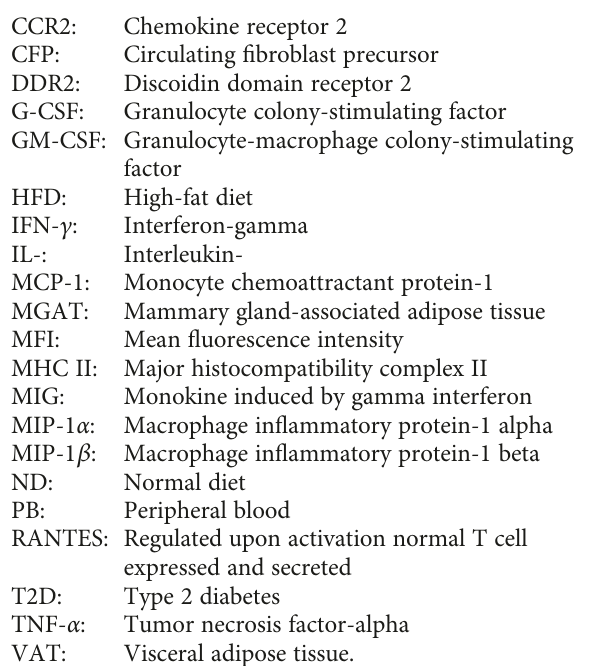
Supplementary Table 1: comparison of high-fat diet (HFD) and normal diet (ND). Supplementary Figure 1: fl ow cytomet- ric controls (unstained cells) from MGAT, VAT, and periph- eral blood of ND-fed, control female C57BL/6 mice. Supplementary Figure 2: total myeloid-derived CD45 + DDR2 + cells in MGAT and VAT of ND- vs. HFD-fed mice. Supple- mentary Figure 3: fl ow cytometric analysis of CD45 + DDR2 - cells in MGAT, VAT, and peripheral blood of ND- vs. HFD-fed mice. Supplementary Figure 4: fl ow cytometric anal- ysis of total CD3e + T cells and CD3e + CD4 + T cells in MGAT, VAT, and peripheral blood of ND- vs. HFD-fed mice. Supple- mentary Figure 5: mediators produced by CD45 + DDR2 + cells cultured in media conditioned by MGAT from HFD- or ND-fed mice. (Supplementary